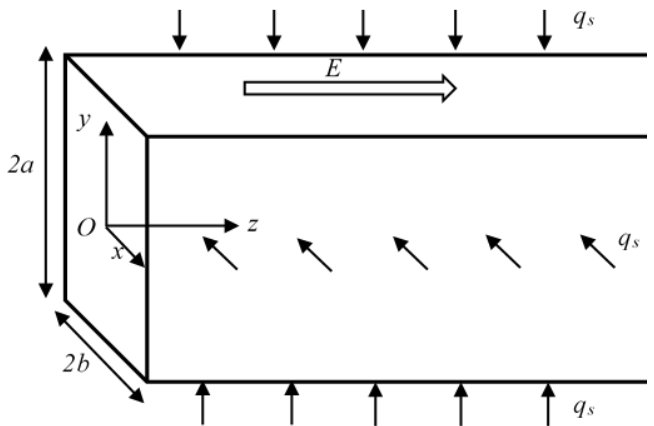
Figure 1. Sketch of the rectangular microchannel with height 2 a , width 2 b , and constant heat flux q s at the walls.